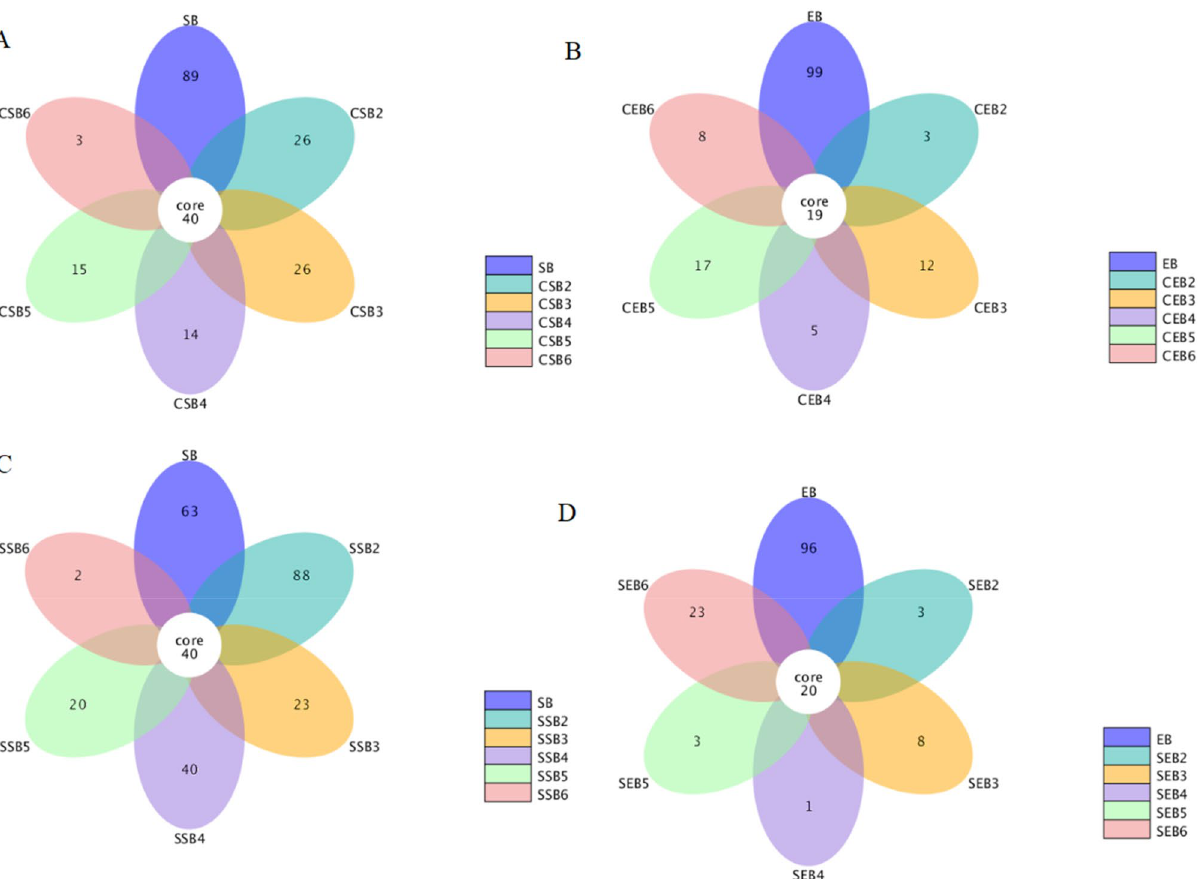
Figure 3. Petal diagrams of OTUs in samples flue-cured through conventional procedure and temperature- and humidity-controlled procedure under different sampling stages (SB: the surface bacteria of fresh tobacco leaves; EB: endophytic bacteria of fresh tobacco leaves; CSB: the surface bacteria of tobacco leaves flue-cured using conventional procedure; CEB: endophytic bacteria of tobacco leaves flue-cured using conventional procedure; SSB: the surface bacteria of tobacco leaves flue-cured using temperature- and humidity-controlled procedure; SEB: endophytic bacteria of tobacco leaves flue-cured using temperature- and humidity-controlled procedure; 2–6 represent different sampling